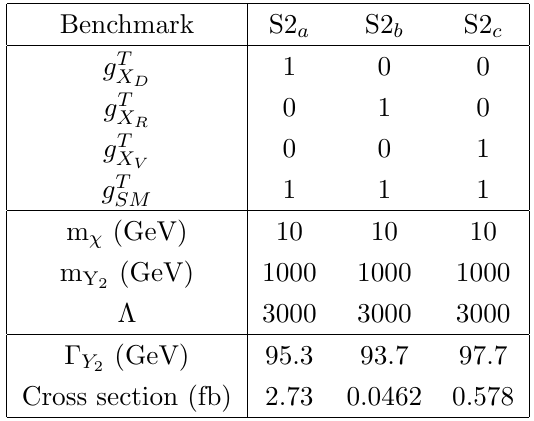
Table 3 . Benchmark scenarios with a spin-2 mediator. Angular coe(cid:14)cients of the three scenarios look all the same.